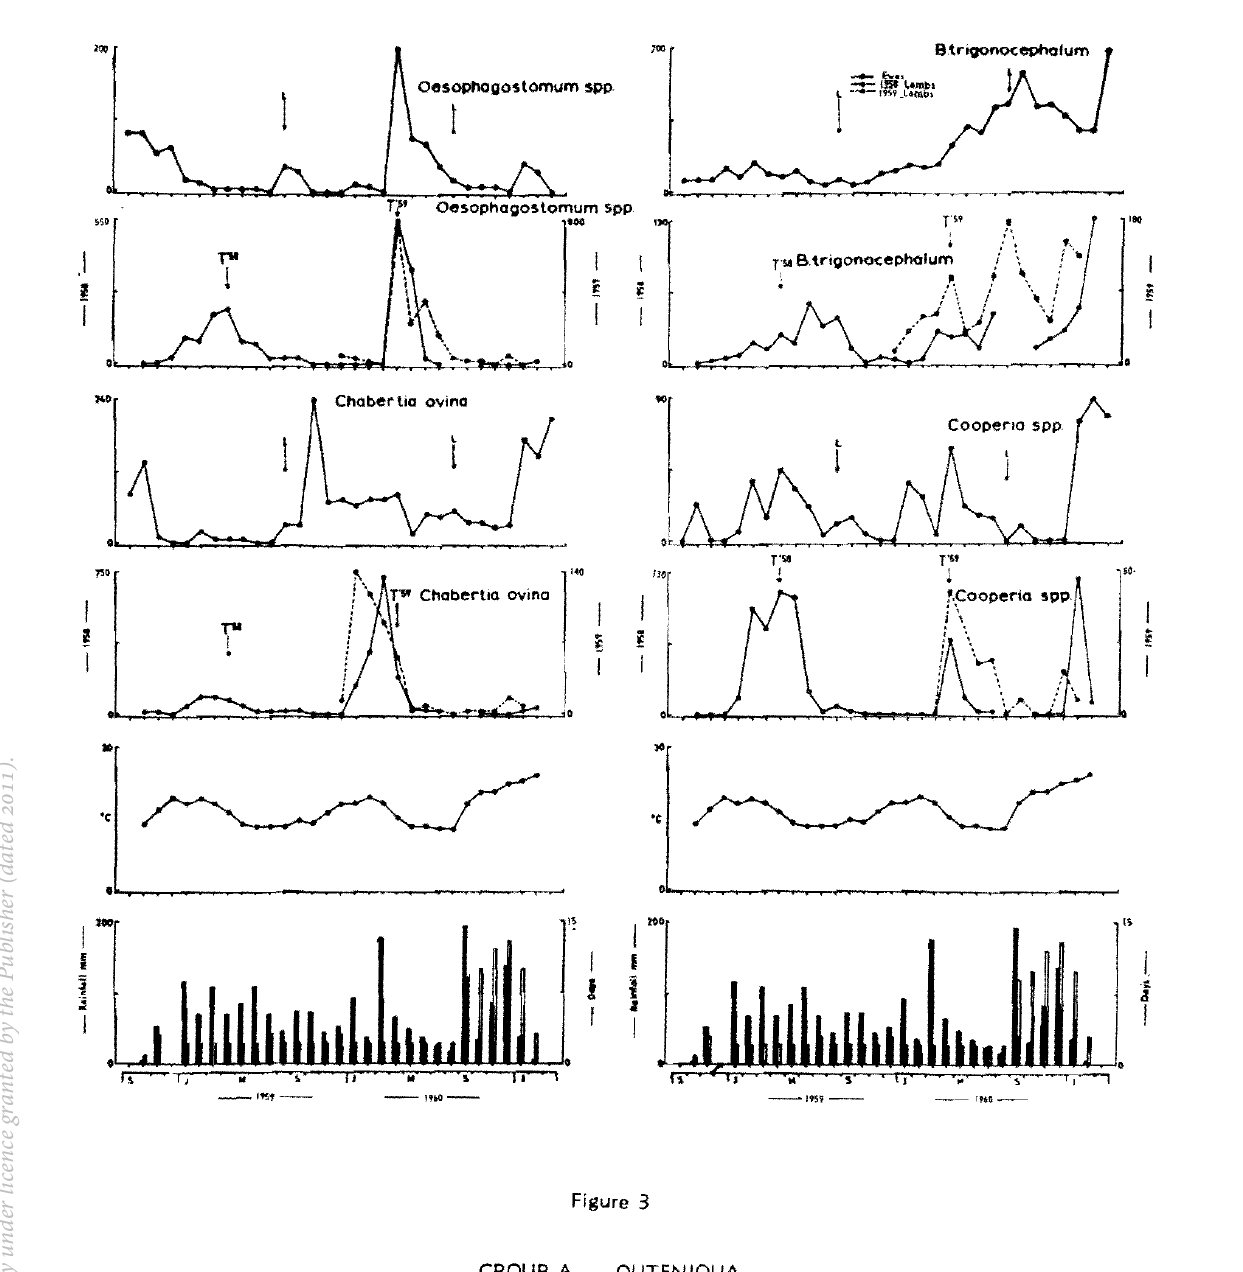
GROUP A - OUTEN IQUA